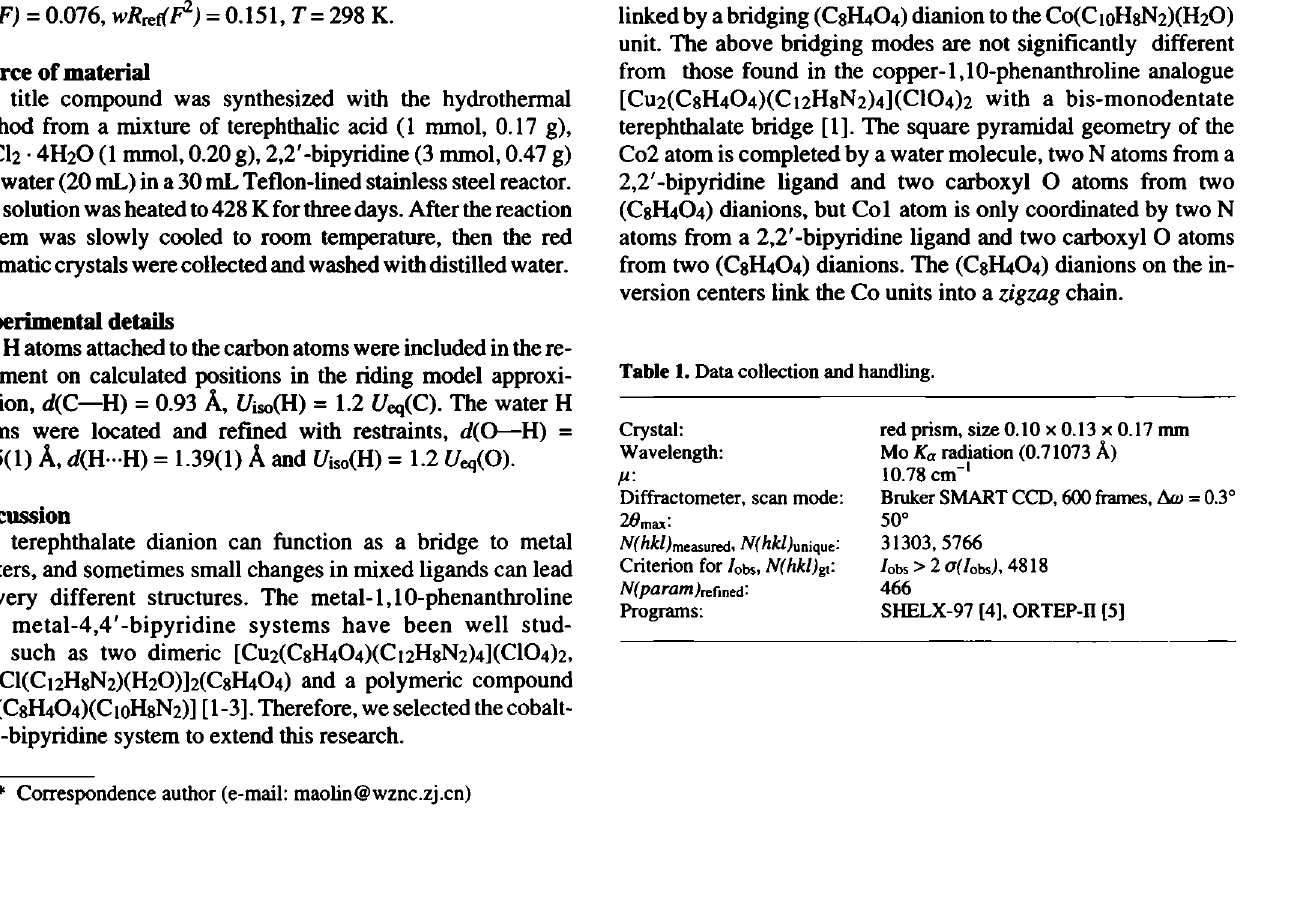
C36H26C02N4O9, monoclinic, P\2\lc\ (no. 14), P = 104.525(1)°, V= 3272.7 A 5 , Z = 4,